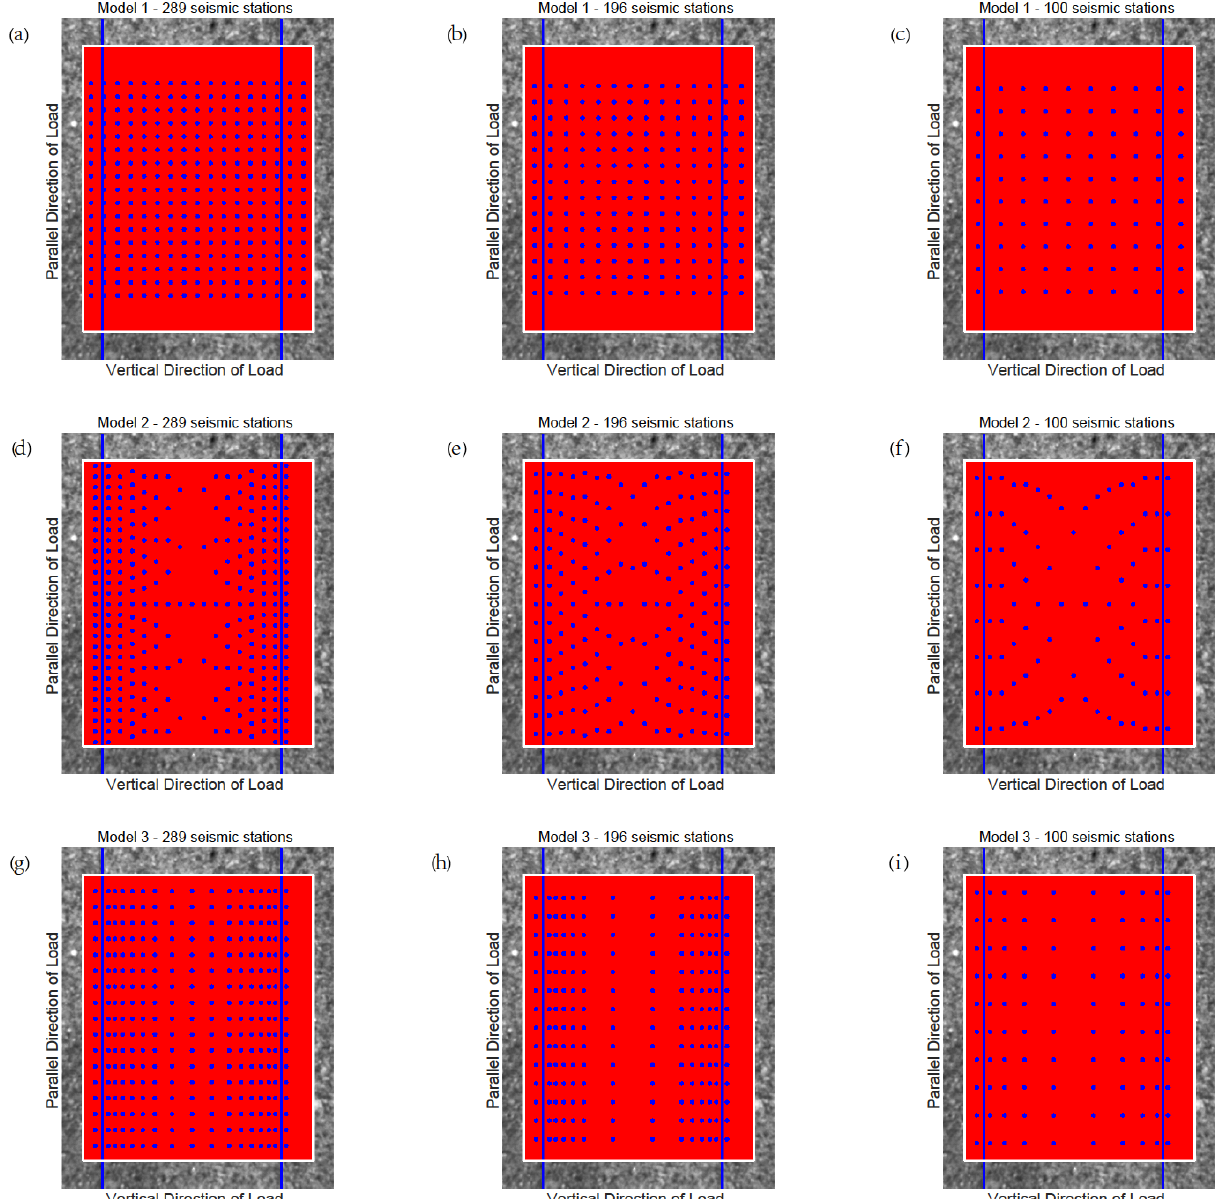
Figure C2. Three kinds of seismic monitoring models with different numbers of seismic monitoring stations for sample